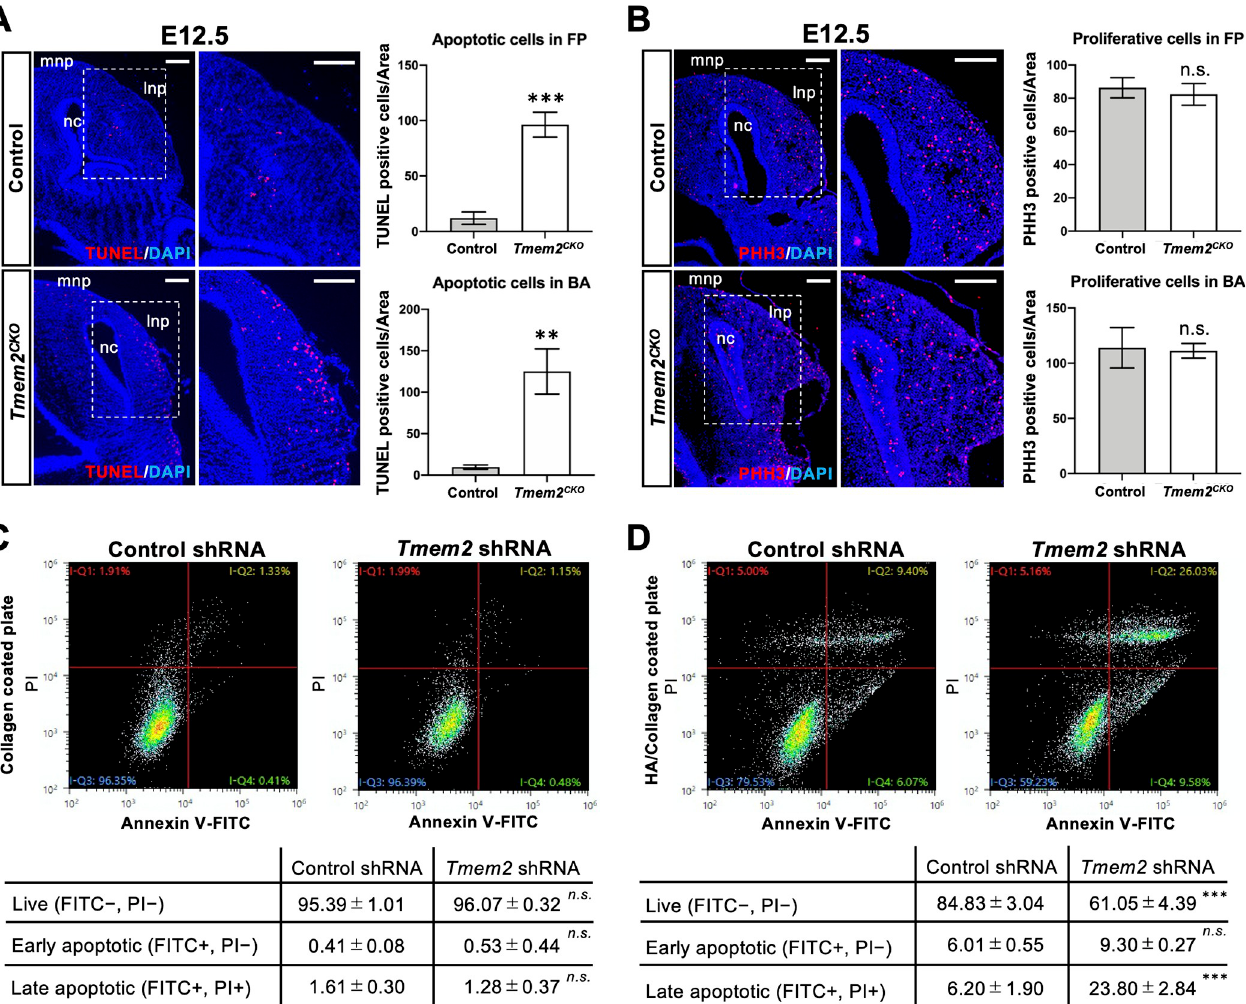
Fig 6. Increased apoptosis of post-migratory NCCs in Tmem2 CKO embryos. ( A ) Analysis of cell death in the facial processes of E12.5 embryos. Transverse sections through the facial processes were analyzed by TUNEL assays. Bar graphs on the right represent the number of TUNEL-positive cells per unit area of the facial processes ( top ) and the first branchial arch ( bottom ). Means ± SD ( n = 3) are shown as horizontal bars. �� p < 0.01, ��� p < 0.001 by unpaired Student’s t -test. ( B ) Analysis of cell proliferation in the facial processes of E12.5 embryos. Transverse sections through the facial processes were stained with anti-PHH3 antibody. Bar graphs on the right represent the number of PHH3-positive cells per unit area of the facial processes ( top ) and the first branchial arch ( bottom ). mnp , medial process; lnp , lateral nasal process; nc , nasal cavity. Means ± SD ( n = 3) are shown as horizontal bars. n . s ., not significant by unpaired Student’s t - test. ( C, D ) Analysis of apoptosis of Tmem2 -depleted and control O9-1 cells cultured on HA-free and HA-containing substrates. Tmem2 -depleted and control O9-1 cells were cultured for 48 h on Col1 alone ( C ) and on Col1/HA mixed ( D ) substrates. Cells were then stained with propidium iodide (PI) and anti- annexin V antibody, followed by the analysis of apoptosis by flow cytometry. Tables show the quantification of live (lower left quadrant in the charts), early apoptotic (lower right quadrant), and late apoptotic (upper right quadrant) cells. ��� p < 0.001; n . s ., not significant by unpaired Student’s t -test. Scale bars, 250 μ m in A and B